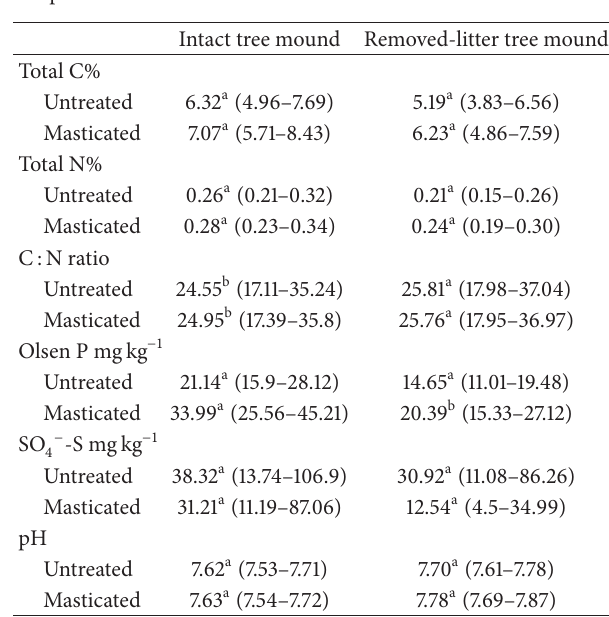
Table 5: Tree mound effects on soil nutrients derived from soil samples.